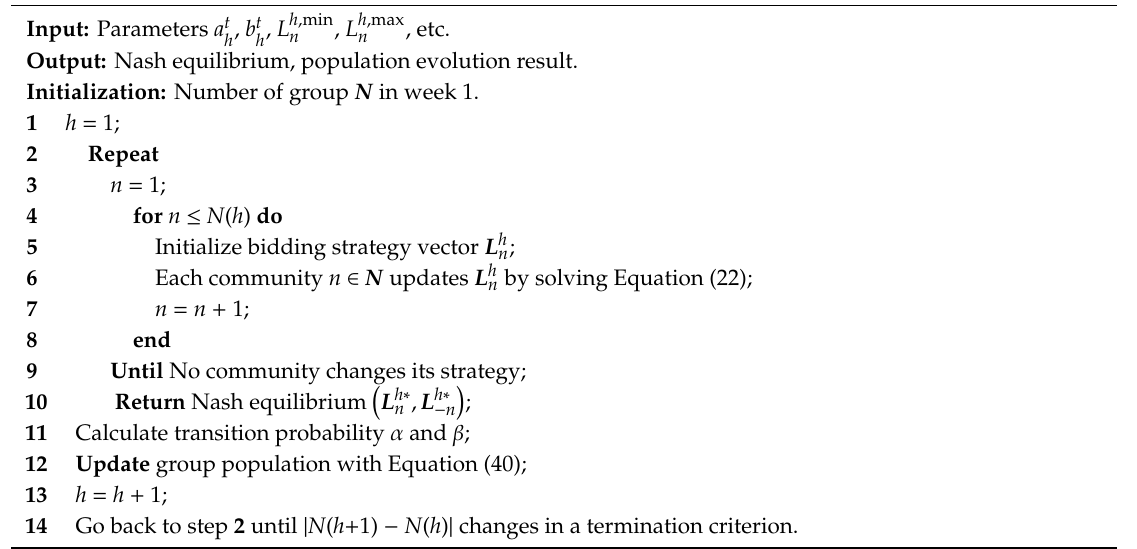
Algorithm 1: Searching for Nash equilibrium and population evolution